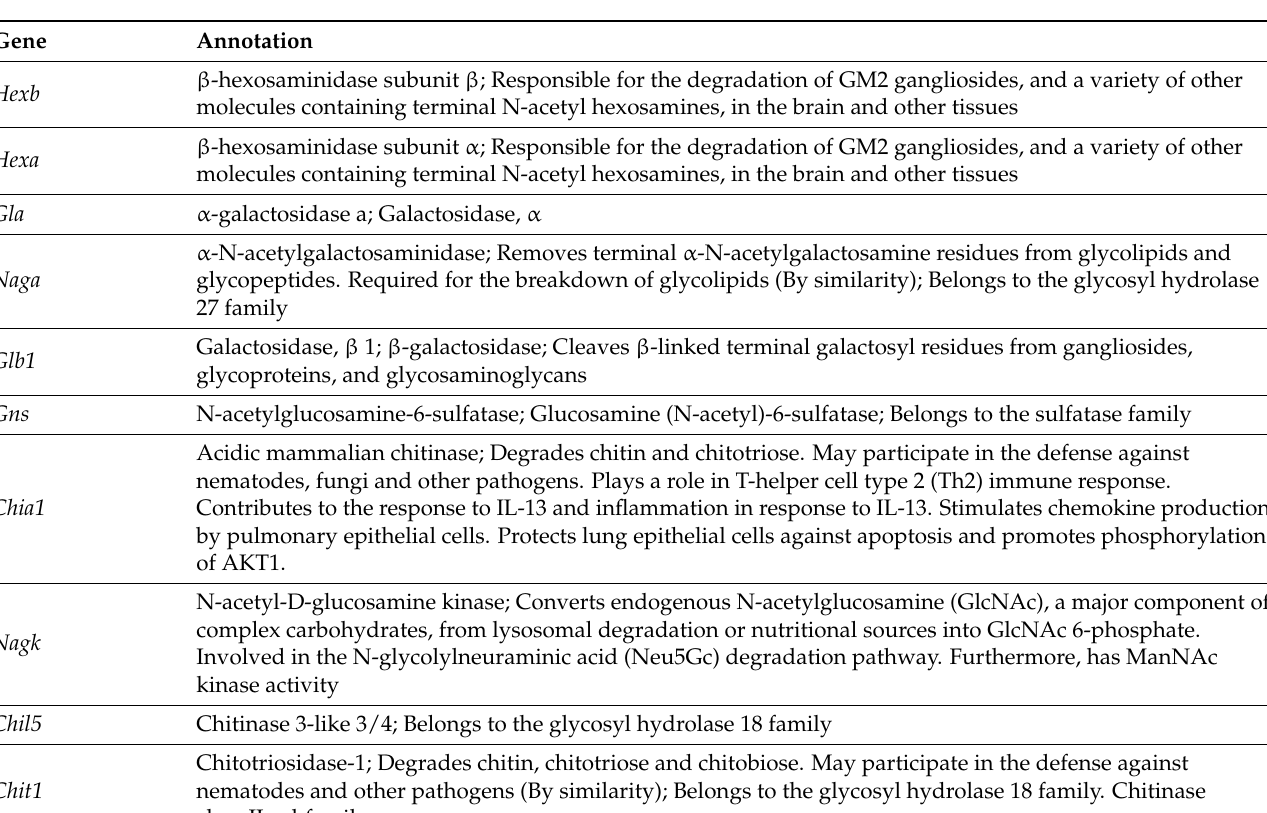
Table 2. Functional annotation of HexB protein association